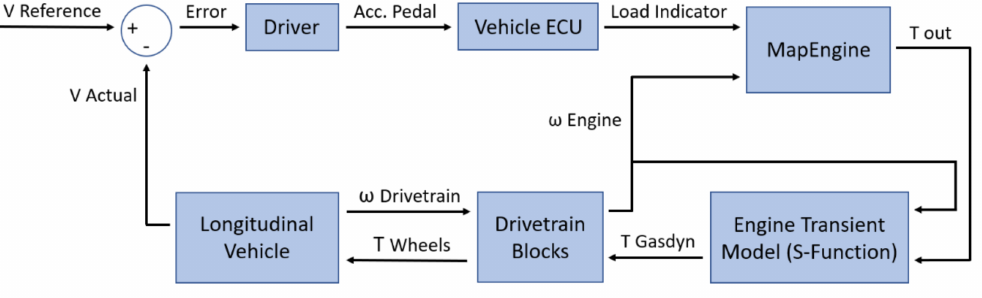
Figure 5. Updated vehicle velocity control; ω : angular speed, V: vehicle speed, T: